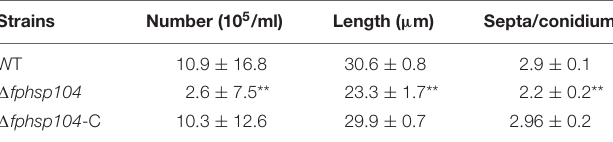
TABLE 1 | Statistical analyses of conidia production and conidial